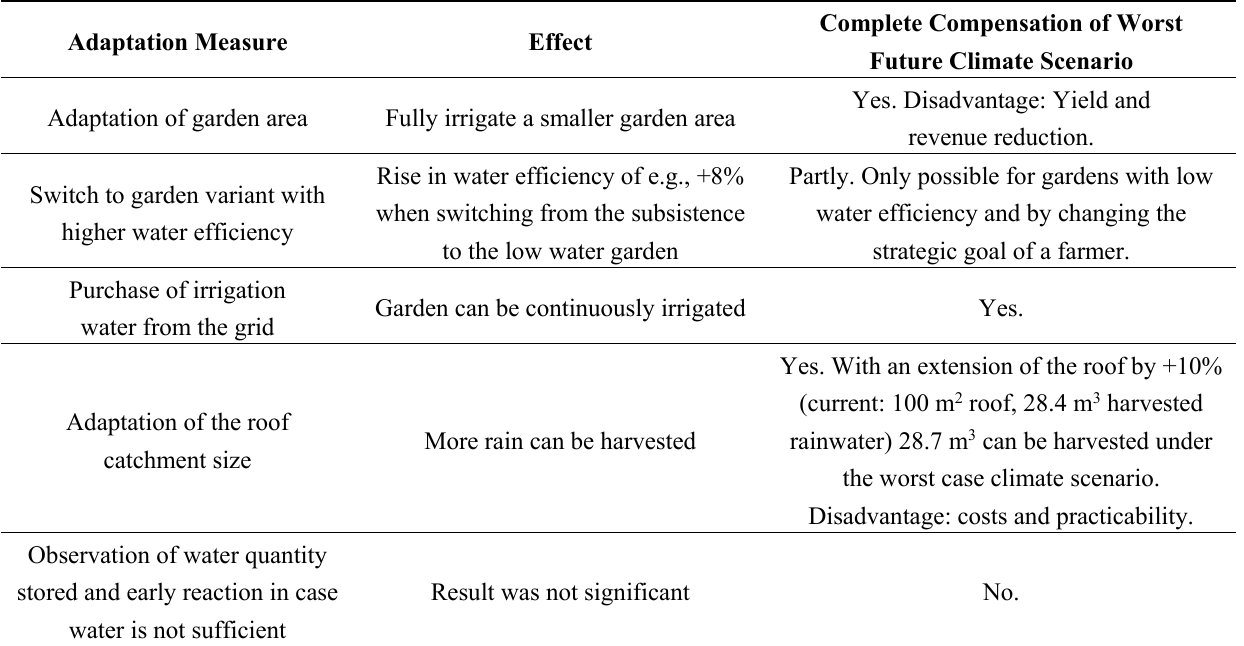
Table 4. Adaptation